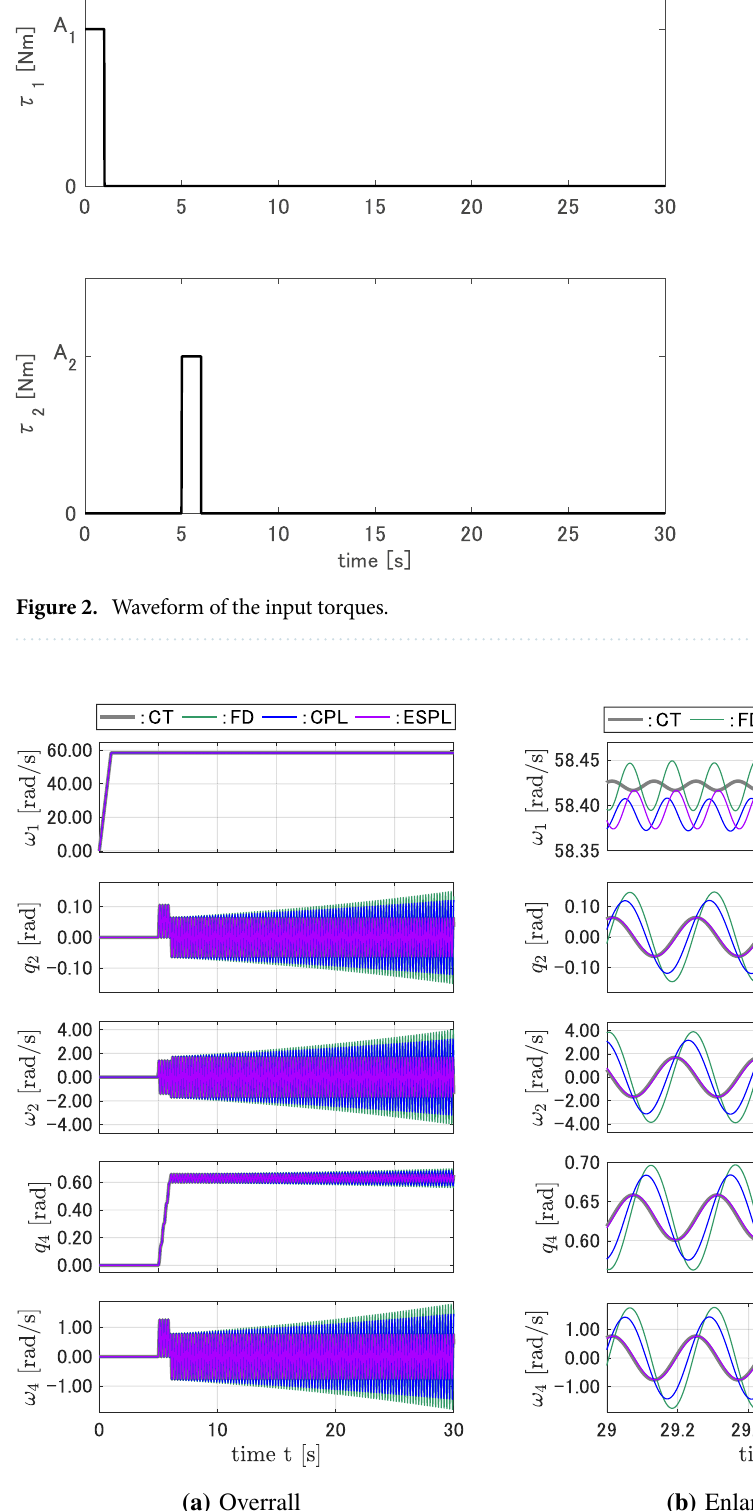
Figure 3. Responses of the CT, FD, CPL, and ESPL models for case